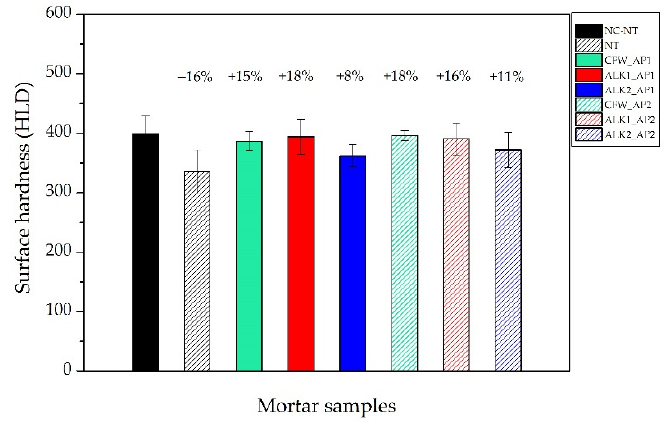
Figure 8. Comparison of surface hardness among: uncracked–untreated samples (NC–NT), cracked– untreated samples (NT) and cracked–treated samples. CFW: Ca(OAcAc) 2 ; ALK1: Ca(OTHF) 2